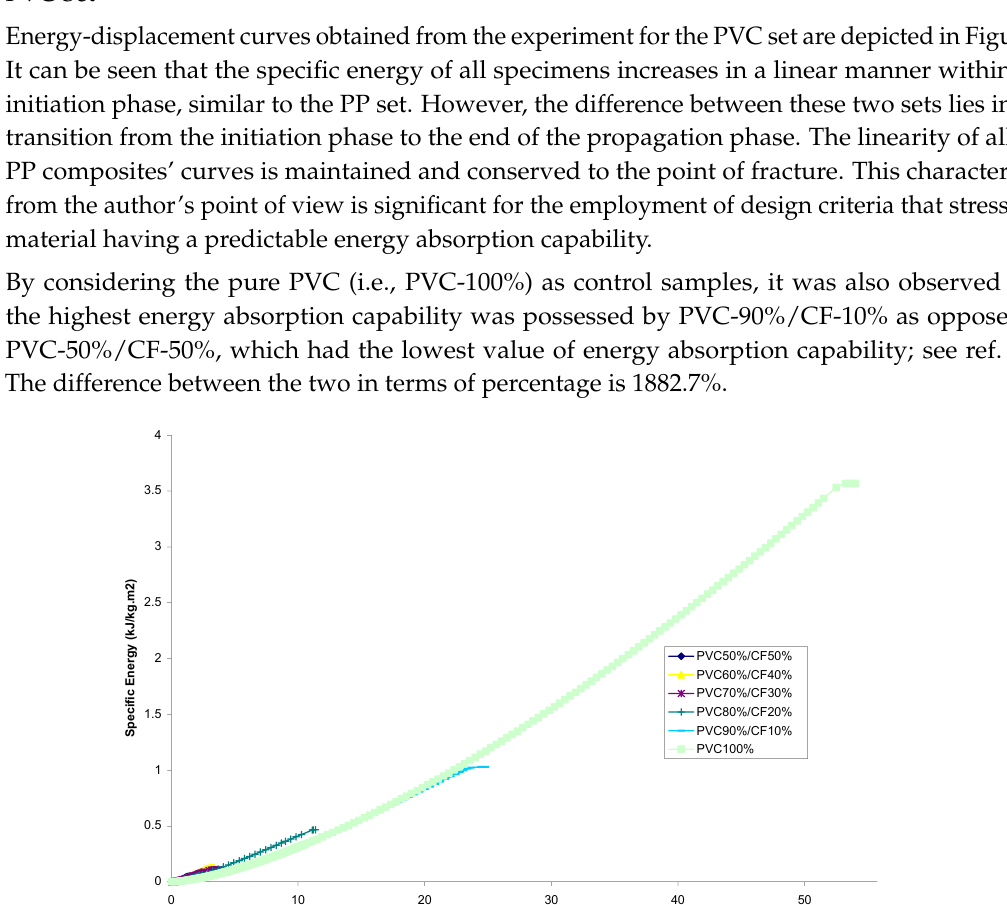
Figure 8. Energy versus displacement for averaged curve of cotton fiber reinforced PP composites. ● PVC Set